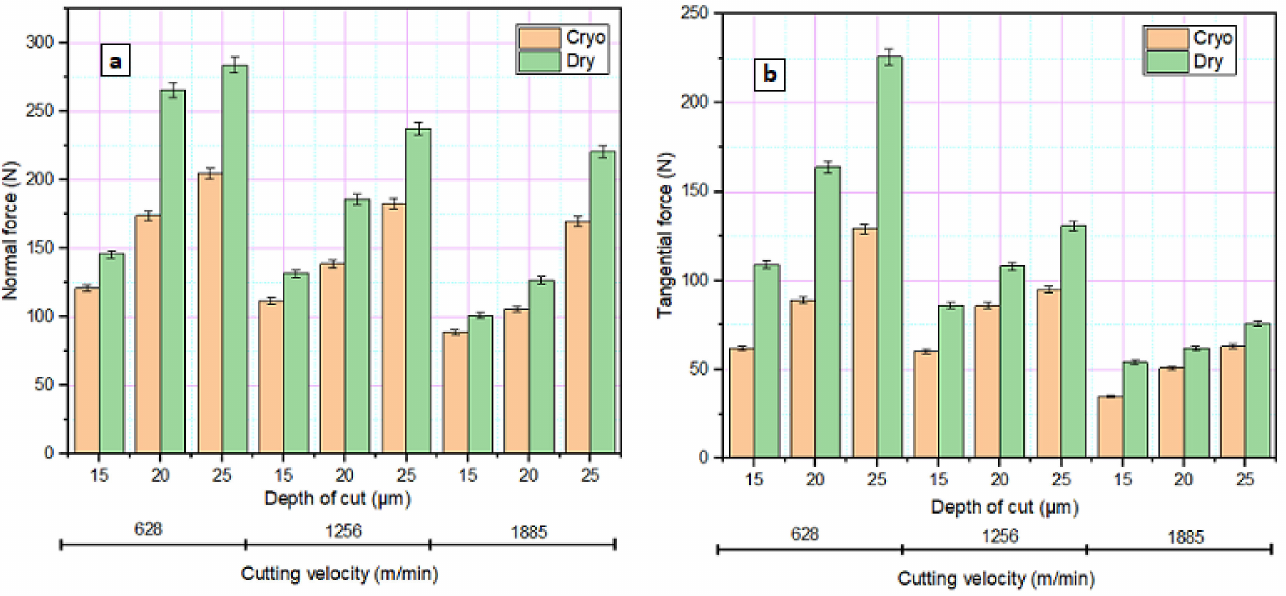
Figure 2. Variation in grinding force under different grinding environments. ( a ) Normal force and ( b ) Tangential